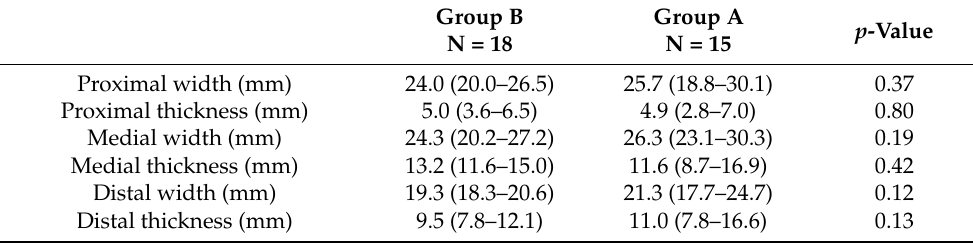
Table 5. Ultrasound measurements on operated tendon; Mann–Whitney test (MW).